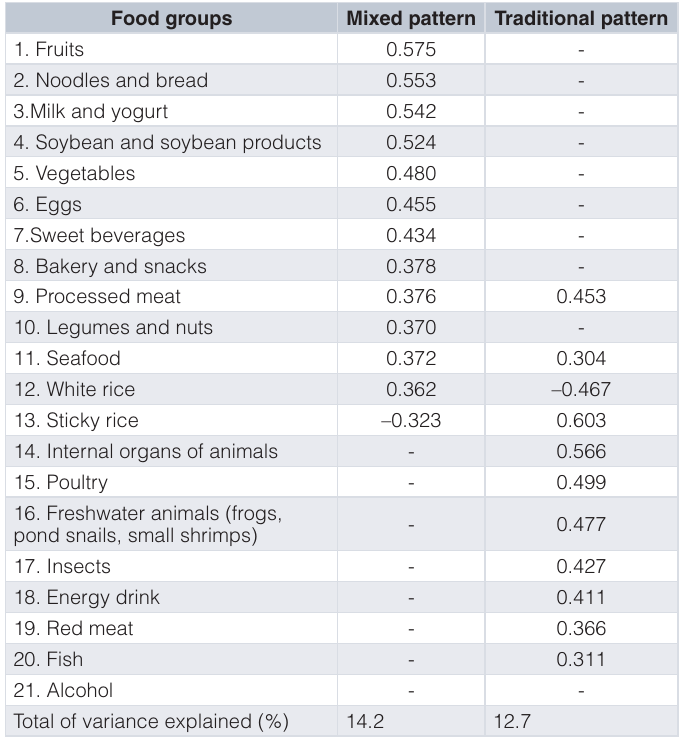
Table 3. Food groups with factor loading for two major dietary patterns. Food groups